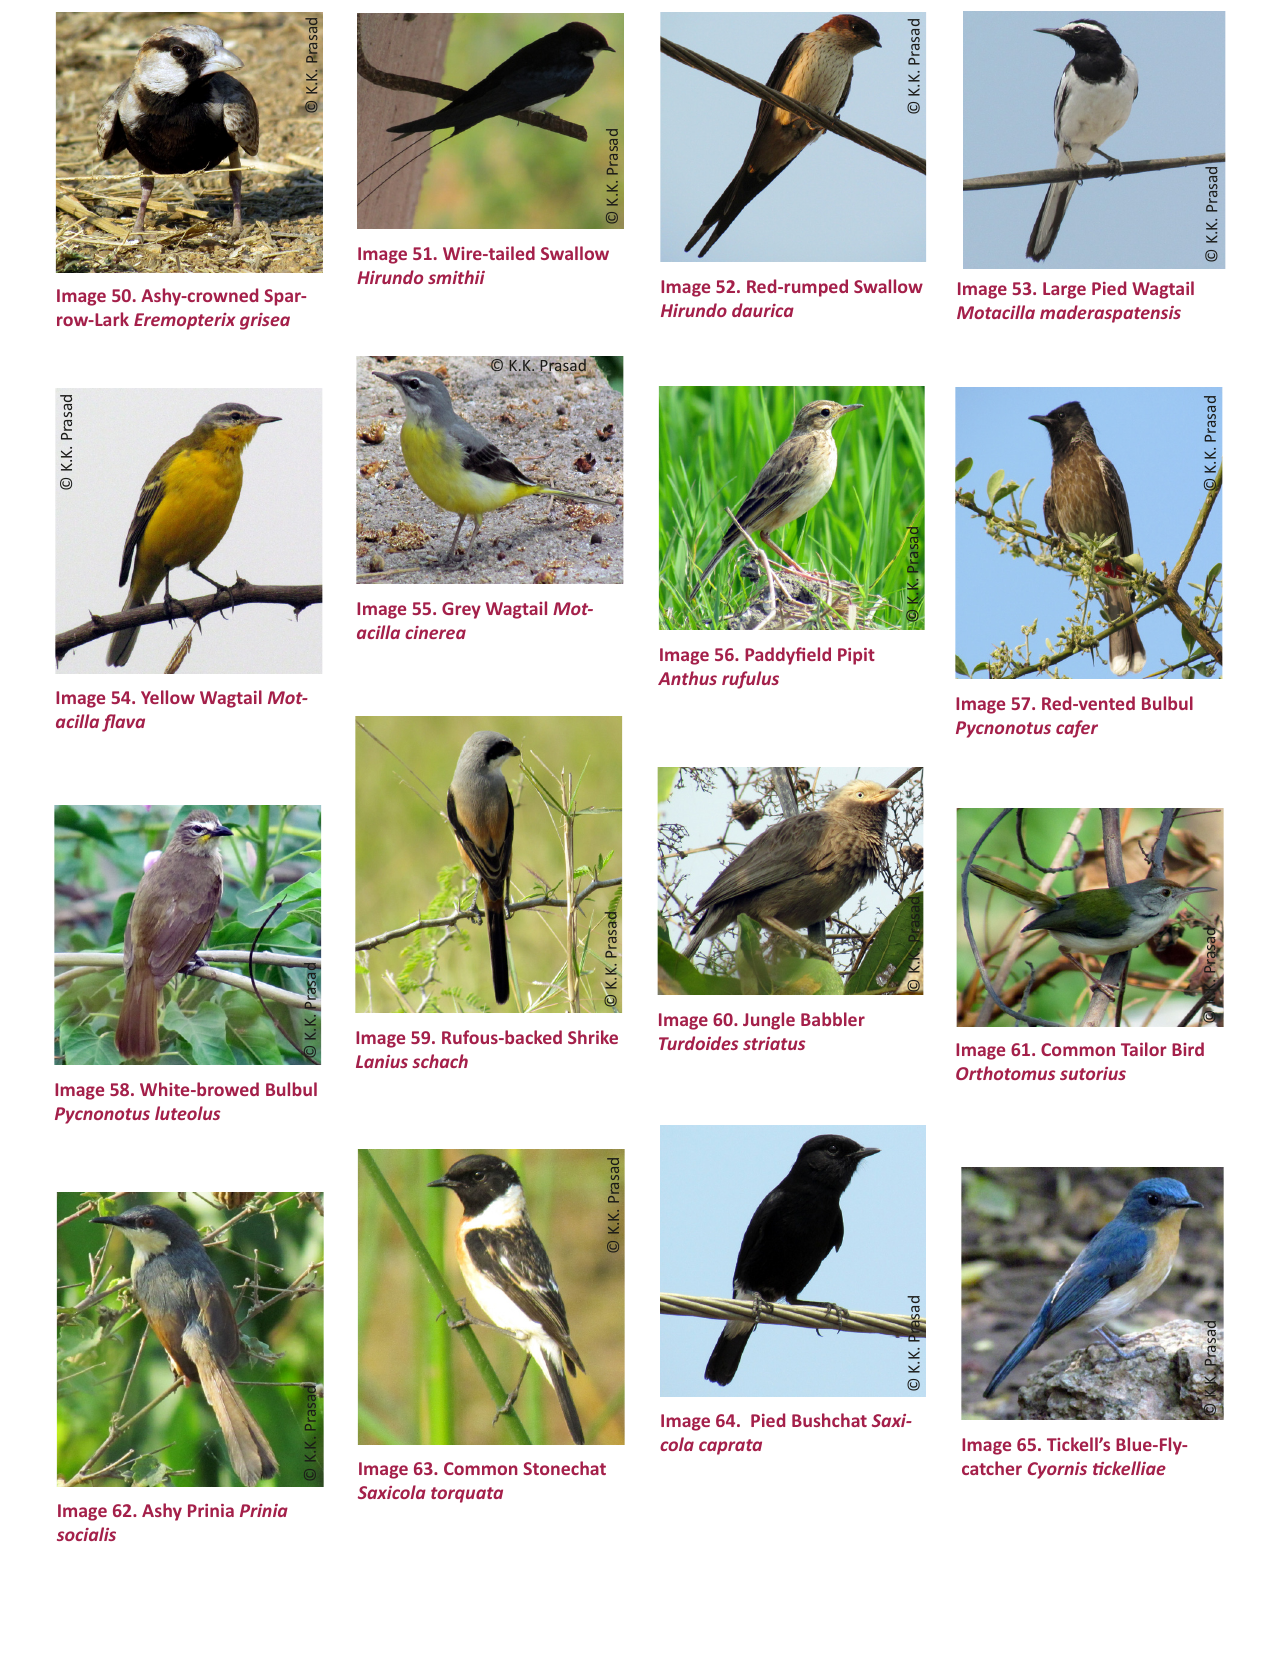
Image 63. Common Stonechat Saxicola torquata